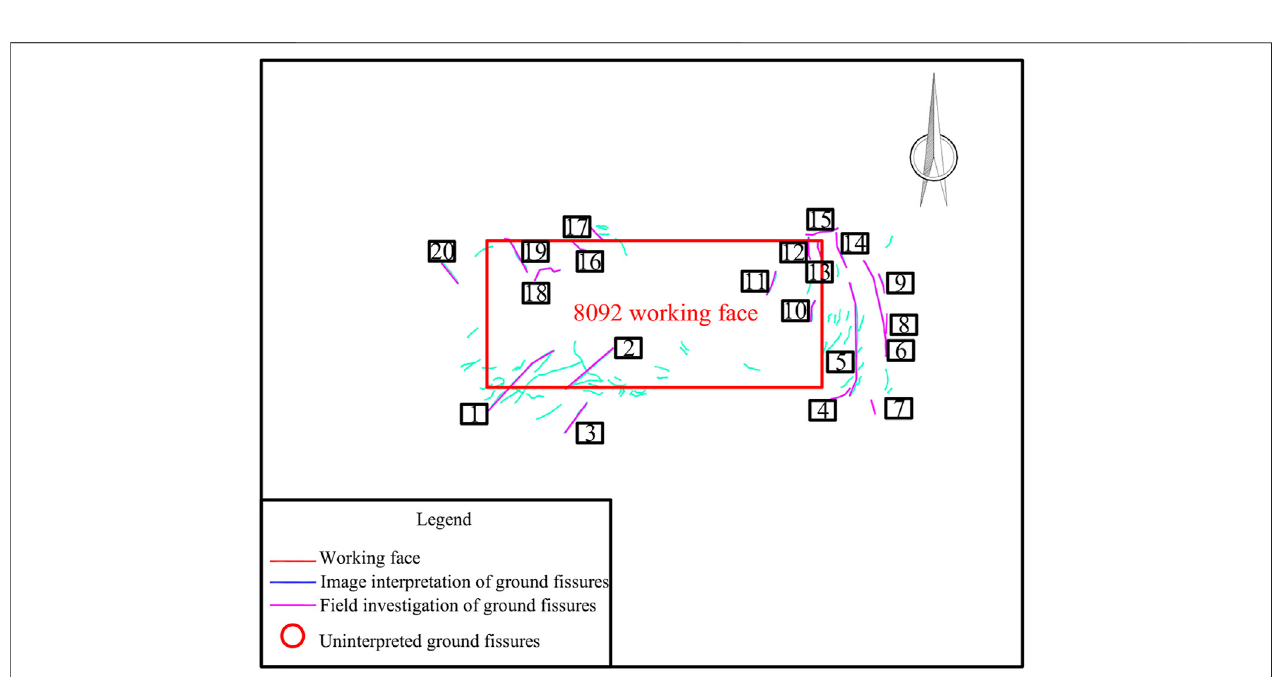
FIGURE 13 | Ground fi ssure survey